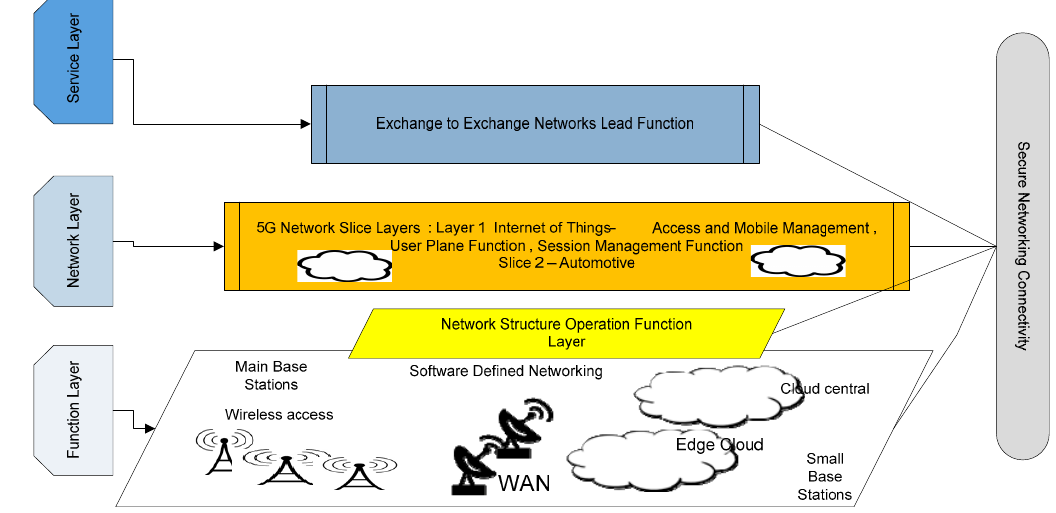
Figure 2. Overview of 5G architecture.